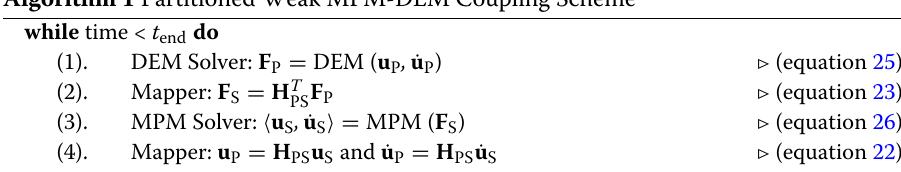
Algorithm 1 Partitioned Weak MPM-DEM Coupling